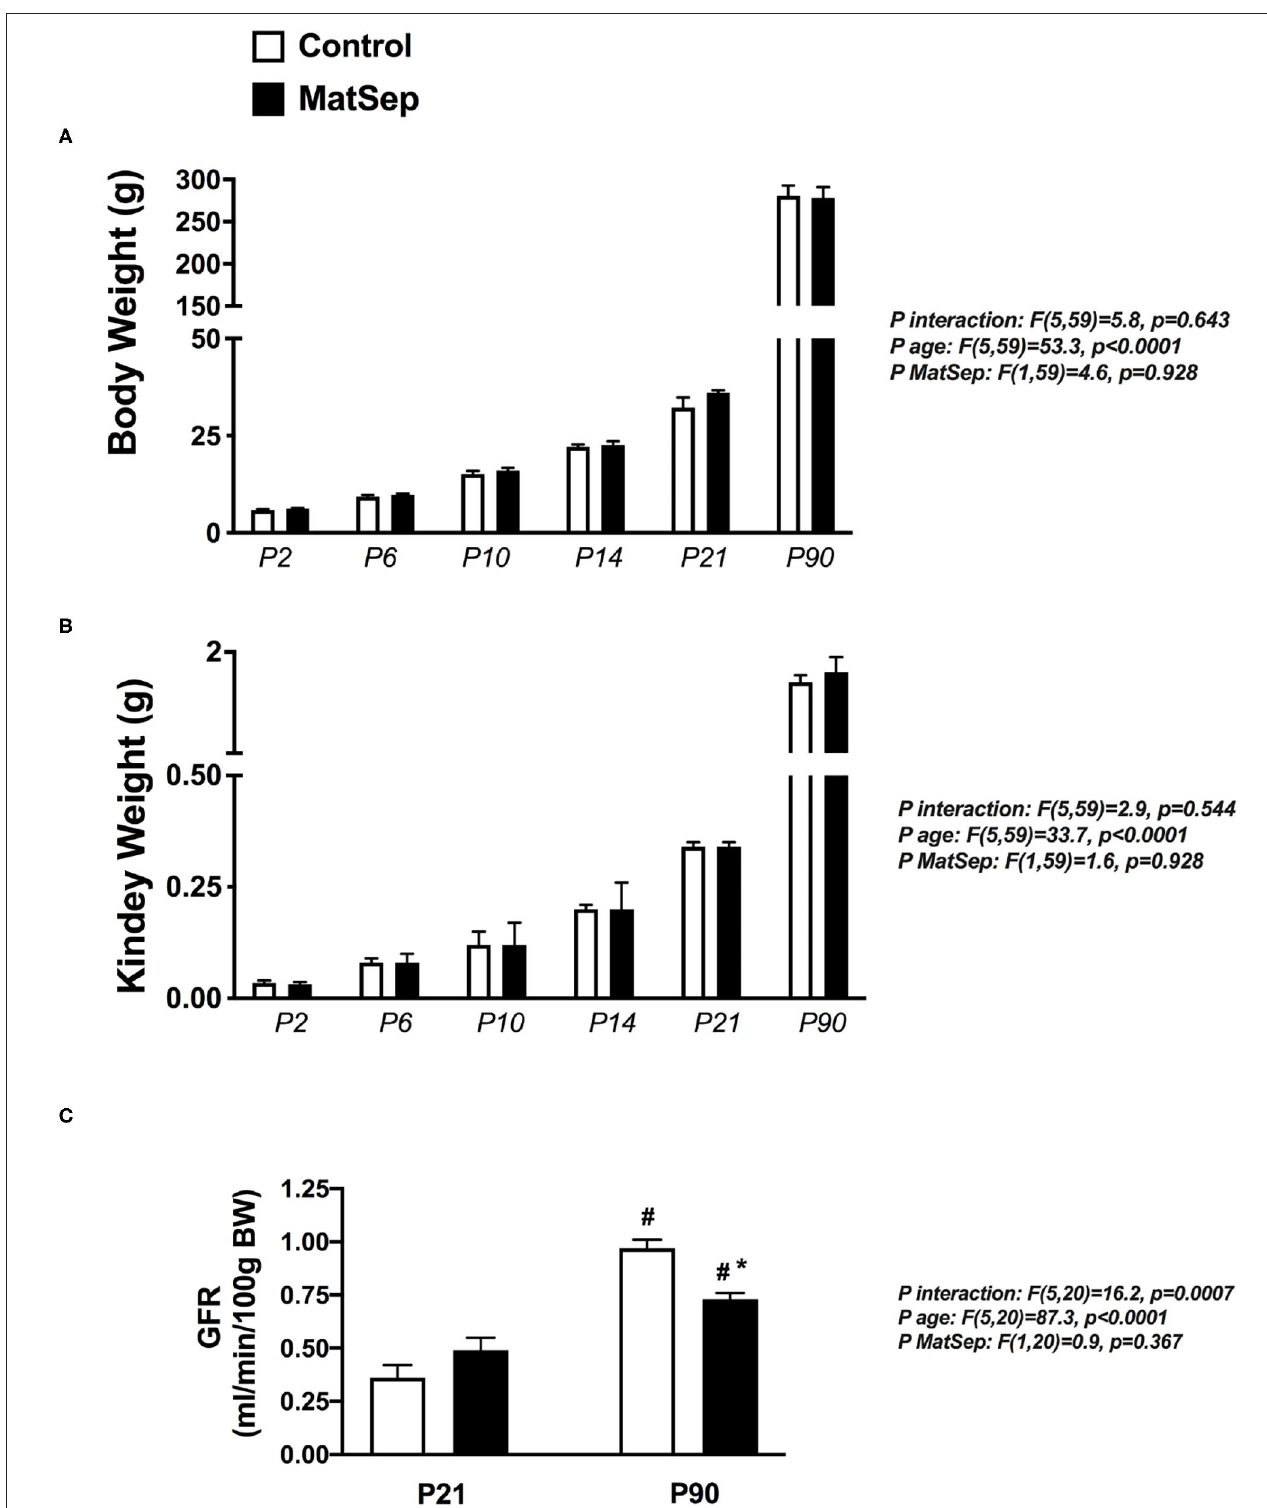
FIGURE 1 | Effect of MatSep on the trajectory from neonatal to adult male rats in: (A) body weight, (B) Kidney, and (C) conscious GFR. # p < 0.05 vs. P21, * p < 0.05 vs. C. P: postnatal day. n = 6–8 per group.